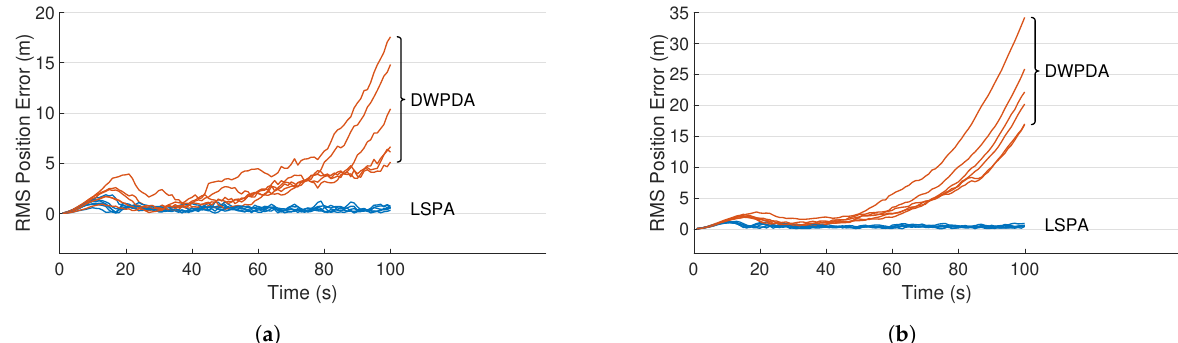
Figure 5. RMS position error for six crossing targets using DWPDA and LSPA with different clutter densities. ( a ) Clutter density λ = 1 × 10 − 4 /m 2 ; and ( b ) clutter density λ = 5 × 10 − 4 /m 2 .